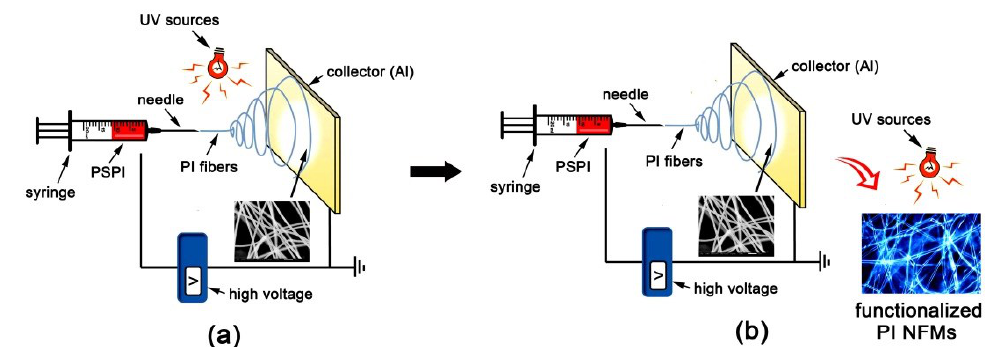
Figure 1. Ultraviolet-assisted electrospinning or electrospraying procedures for PI NFMs. ( a ) “ UVAES ” ; ( b ) modified “ UVAES ” .